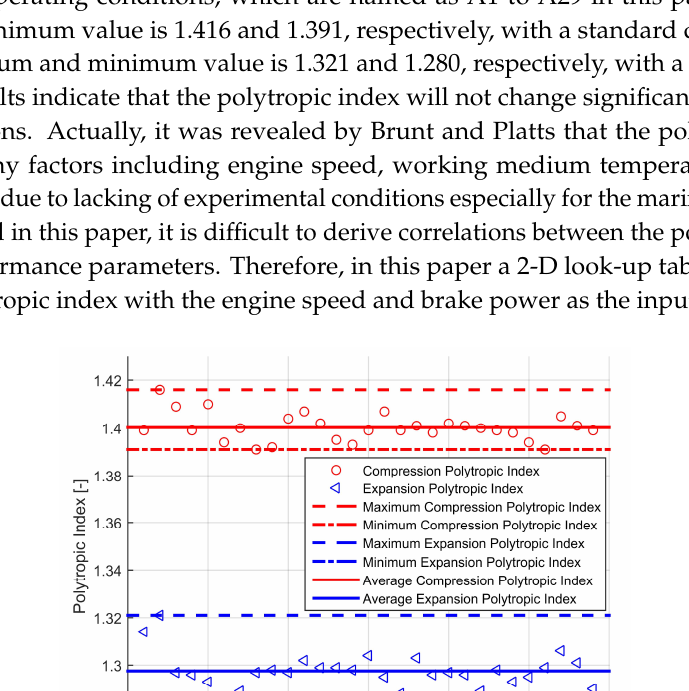
Figure 15. Relationship between log(V) and log(p) and linear fitting result for the compression and expansion process.